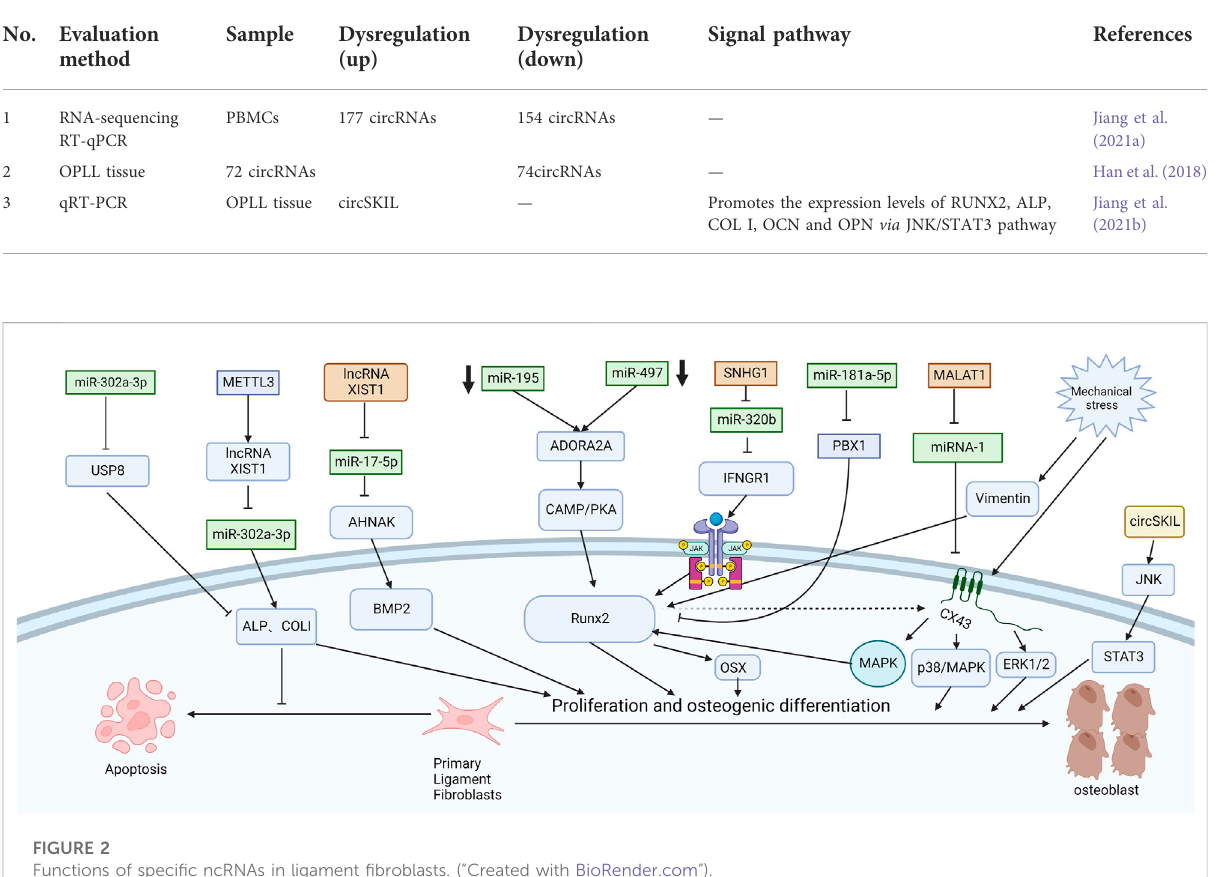
TABLE 3 CircRNAs expression pro fi les in OPLL.